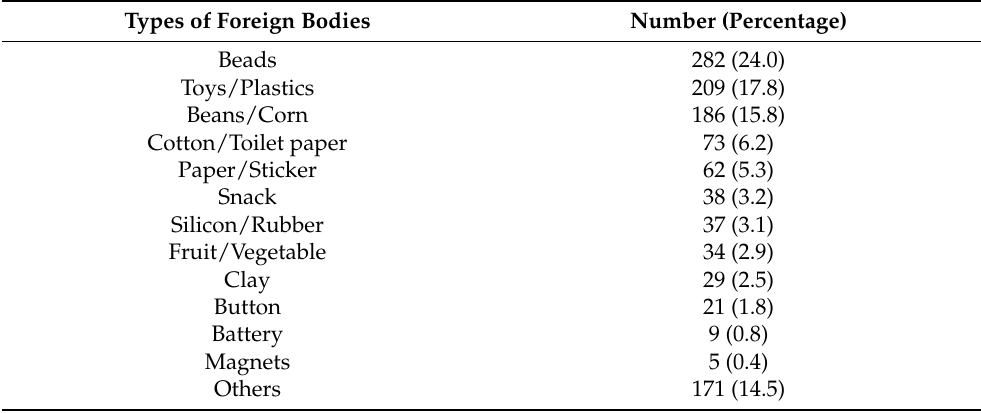
Table 1. Types of foreign bodies in nasal cavity.